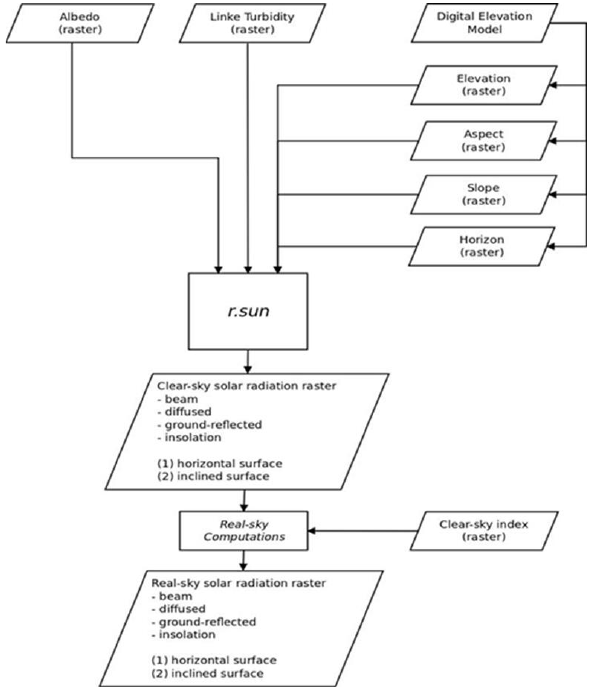
Figure 11. Workflow for solar energy resource assessment using LiDAR DEM